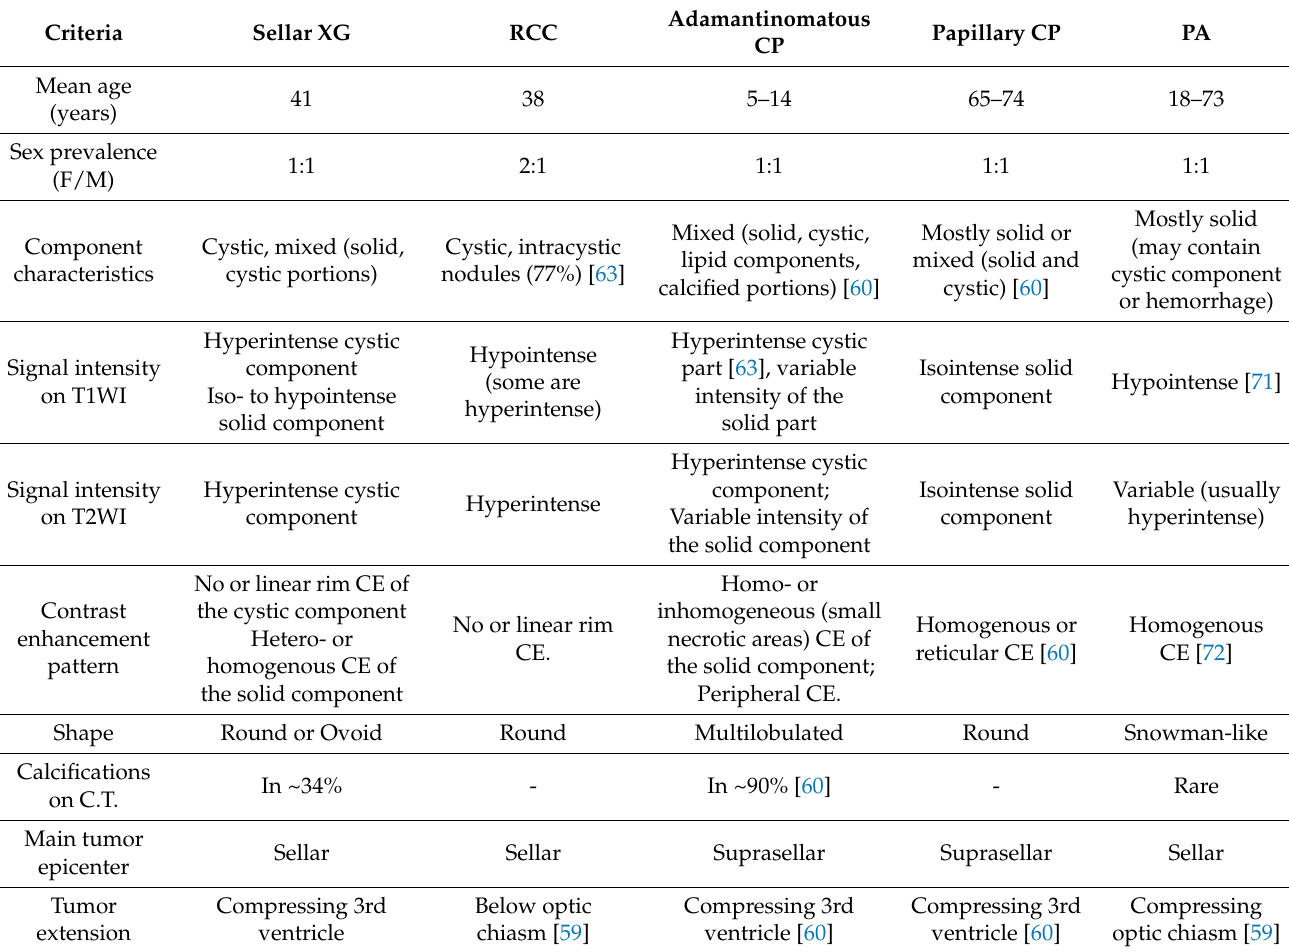
Table 2. Differential diagnosis of sellar XG based on imaging features. Abbreviations: CE = contrast enhancement; CP = craniopharyngioma; CT = computed tomography; F/M = female/male